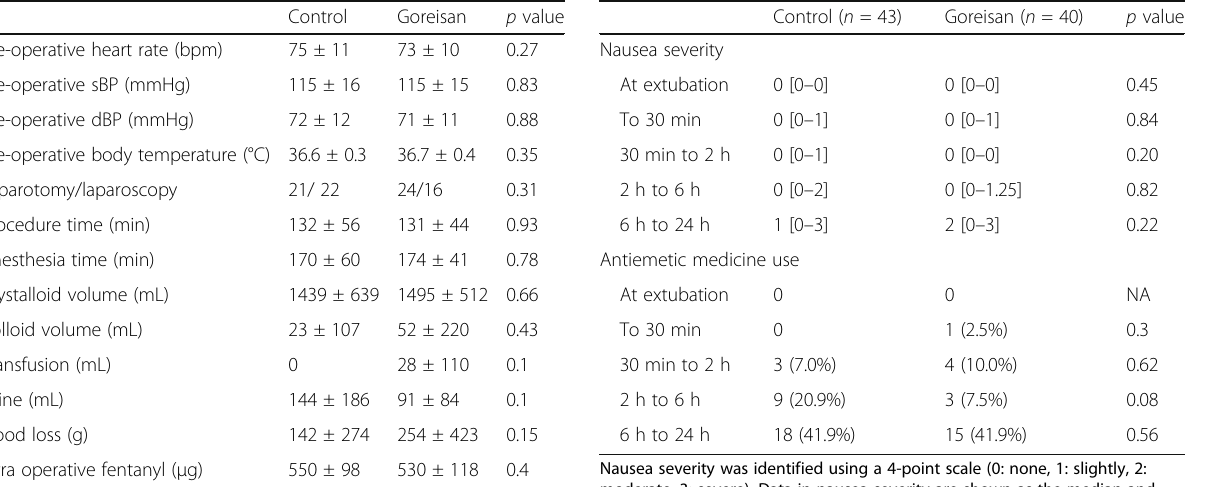
Table 4 Intraoperative and postoperative parameters